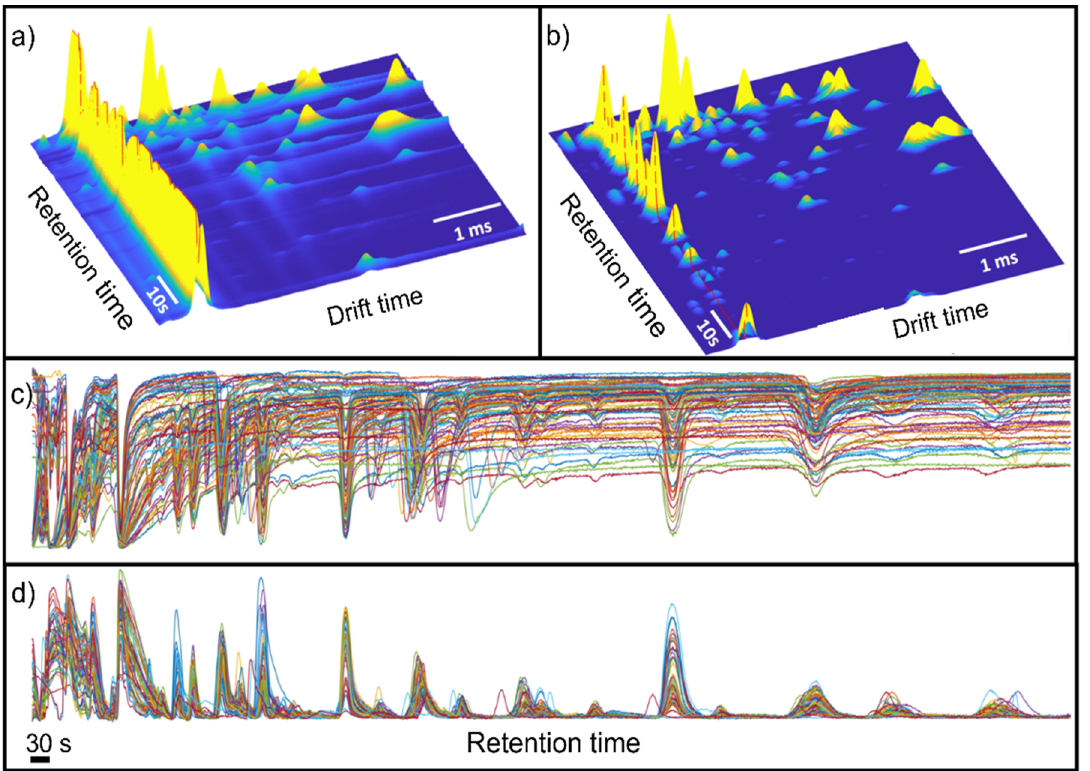
Figure 2. ( a ) Raw and ( b ) pre-processed GG-IMS matrix from a randomly selected black-label ham sample. For visualization purposes, the RIP region was inverted in ( b ). The dashed red line shows the RIP vector. ( c ) Raw RIP vector; ( d ) pre-processed RIP vector.